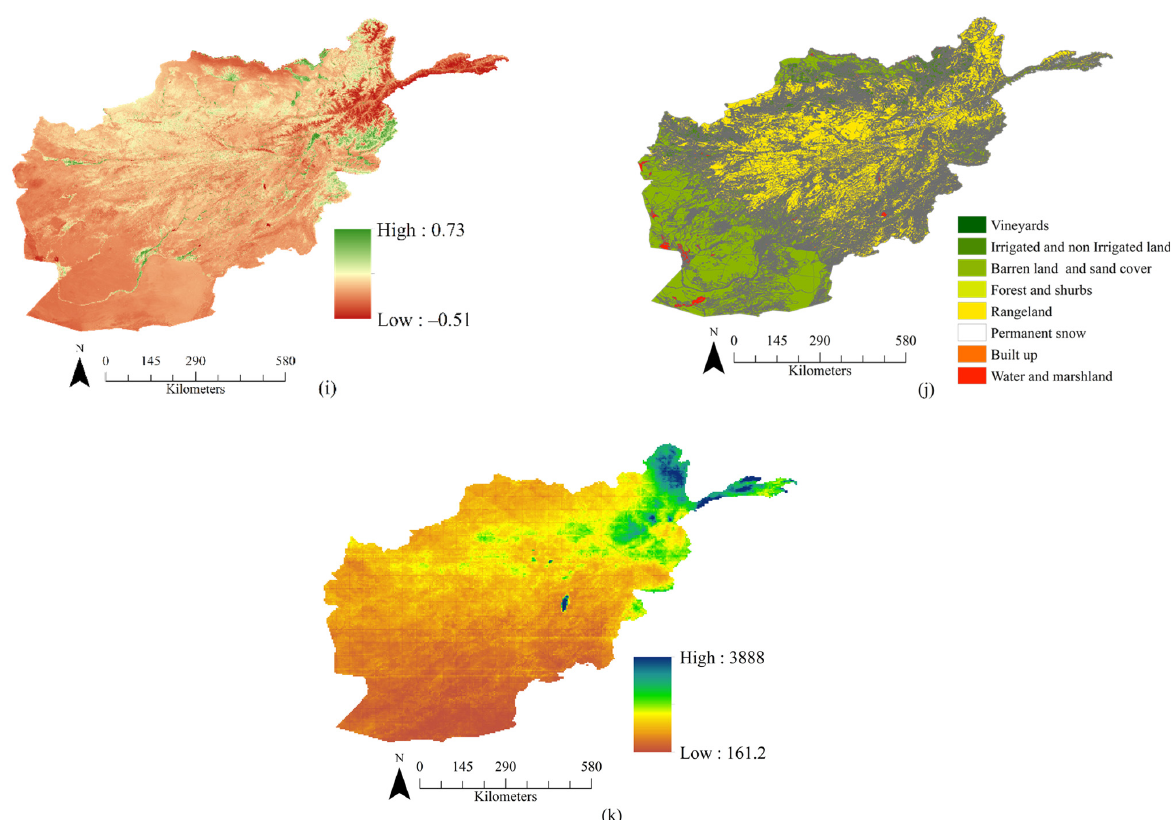
Figure 3. Multicriteria maps for land suitability analysis: ( a ) elevation (m), ( b ) slope (%), ( c ) river, ( d ) road, ( e ) soil depth, ( f ) soil pH, ( g ) soil texture, ( h ) soil salinity, ( i ) normalized difference vegetation index (NDVI), ( j ) land use/land cover (LULC), and ( k ) rainfall (mm/h).